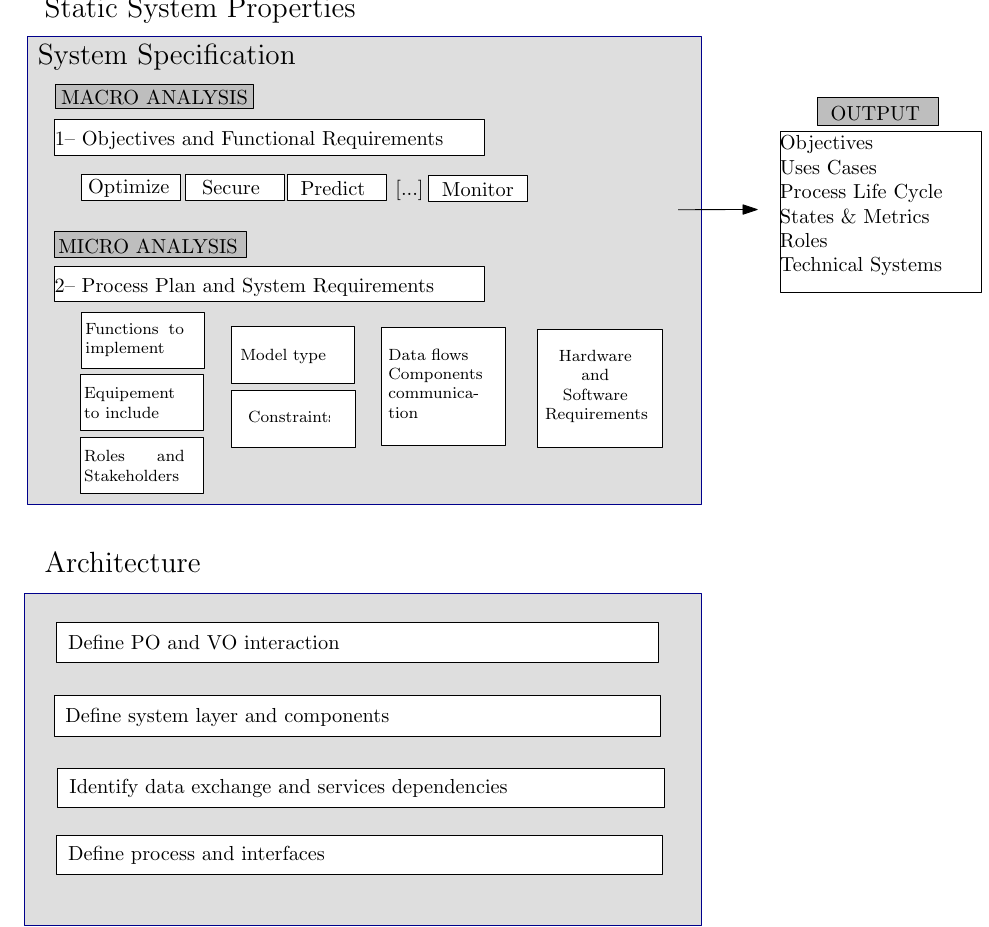
Figure 2. Methodological design of Digital